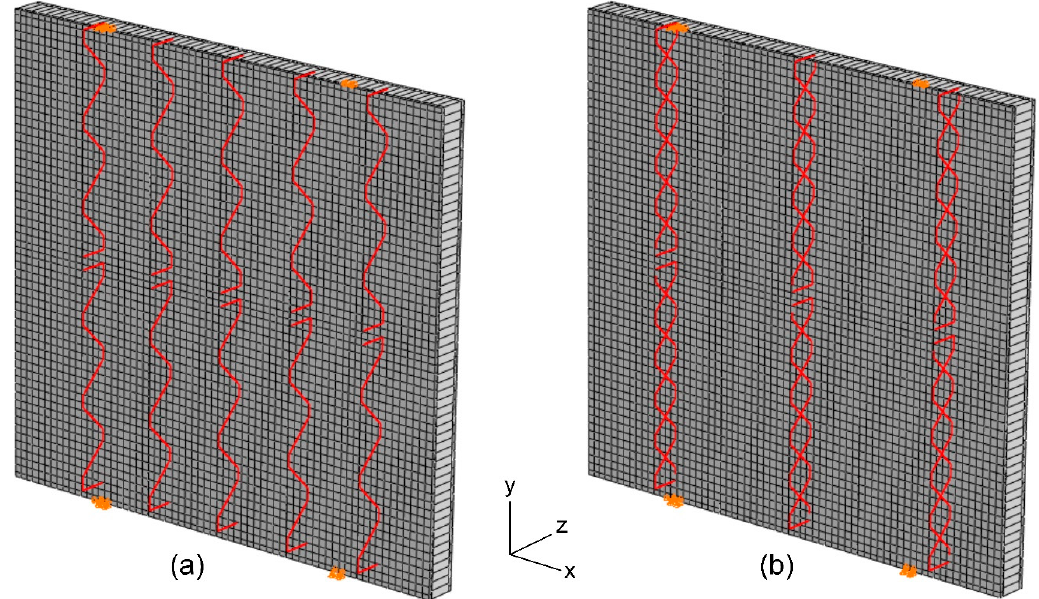
Figure 10. Schematic of FE model developed for the wind load testing with ( a ) single connector (S) configuration ( a ) and double connector (D) configuration ( b